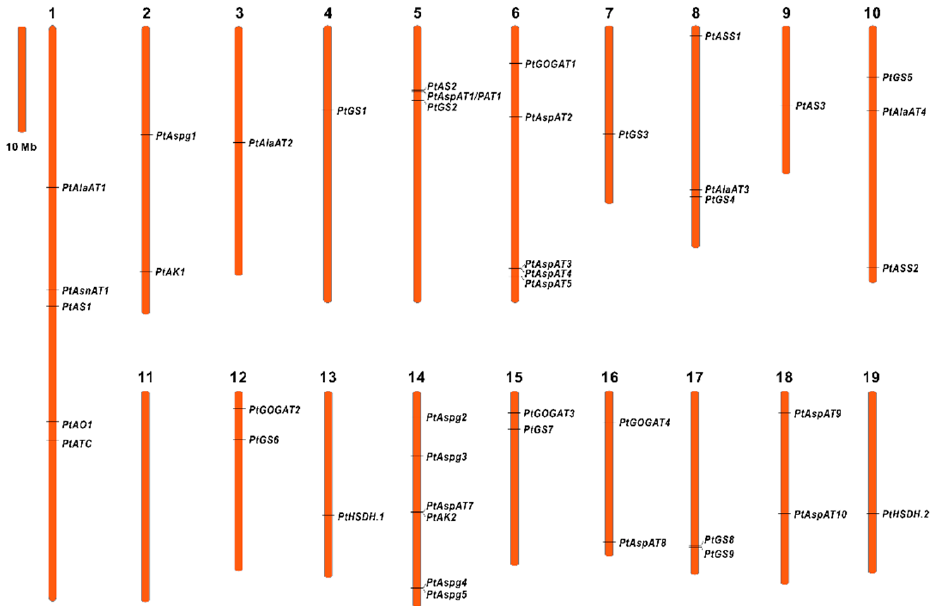
Figure 2. The chromosomal distribution of isogenes involved in Asp metabolic pathways. Forty-four isoenzyme genes were anchored on 19 chromosomes in Populus except for Chromosome 11.